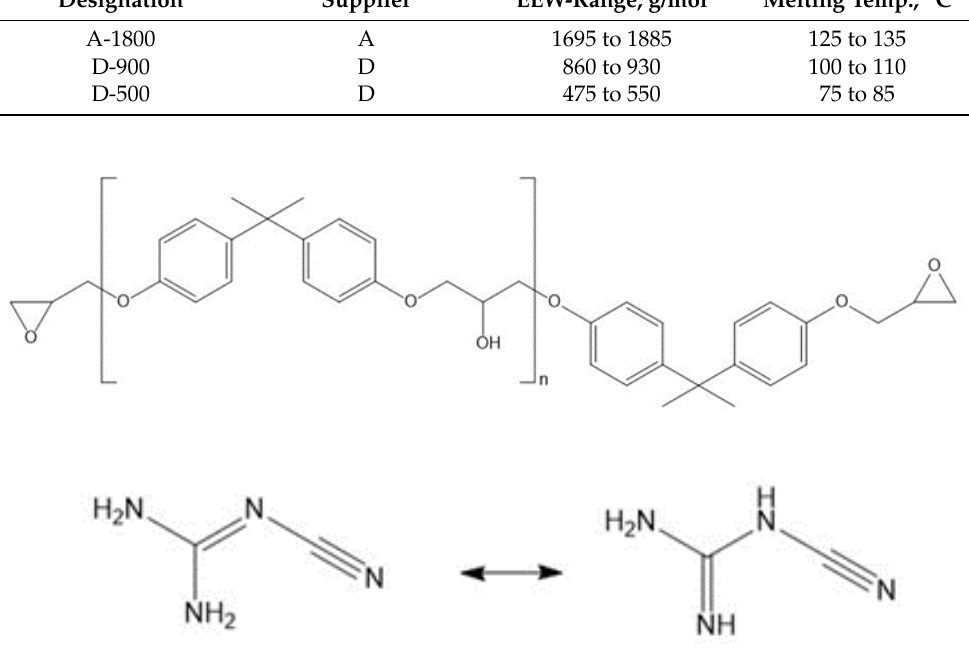
Figure 1. Chemical structure of DGEBA with repeating unit n ( top ) and DICY ( bottom ) with its two tautomeric forms, diamino ( left ) and amino-imino ( right ).